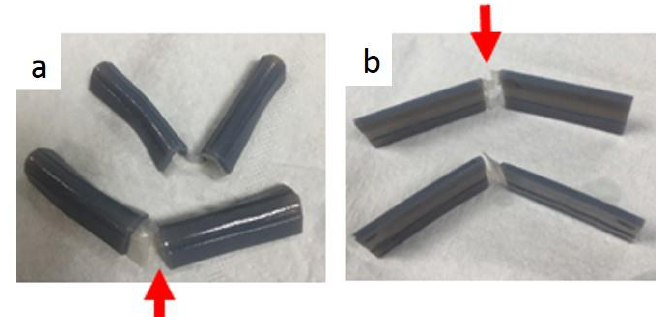
Figure 25. Fracture for the 0.1 mm sample. ( a , b ) Fracture at folding line 1.